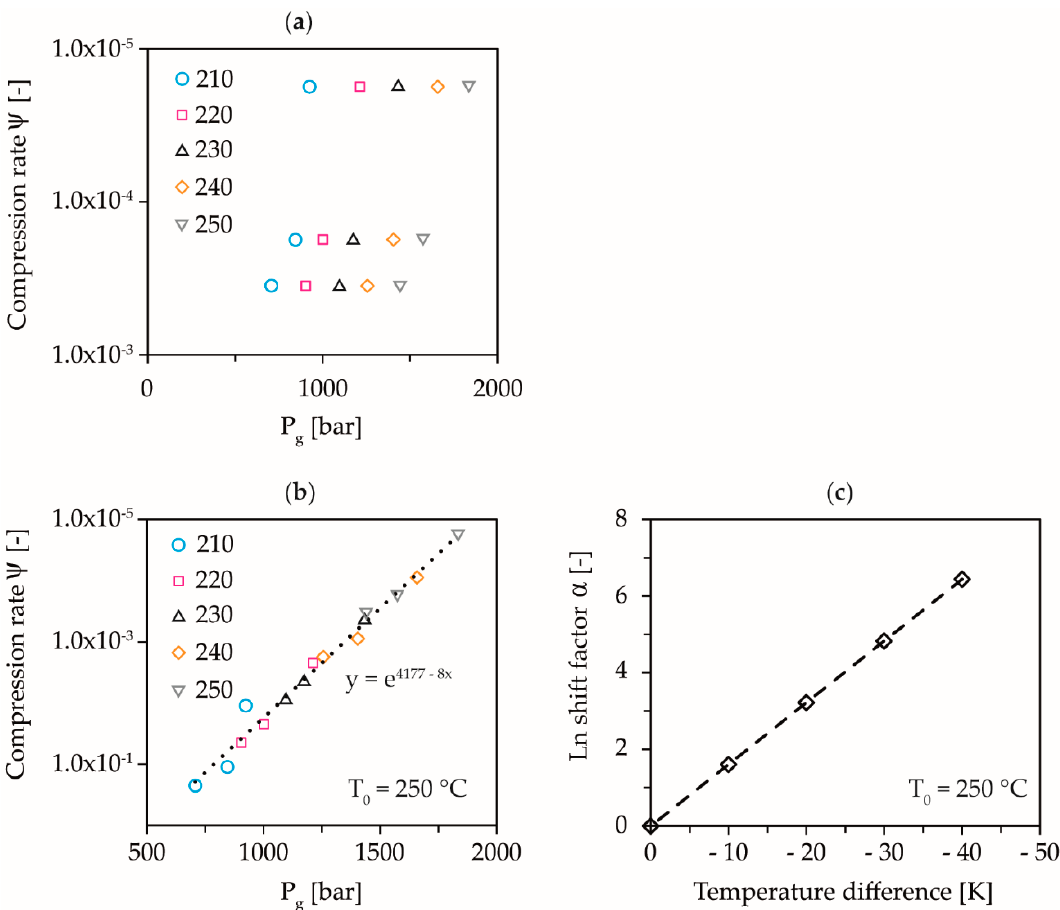
Figure 4. Determined dynamic pressure-induced solidification as a function of temperature and compression rate ( a ), shift of the dynamic pressure-induced solidification curves to a master curve at 250 °C ( b ), and temperature shift factors ( c ).